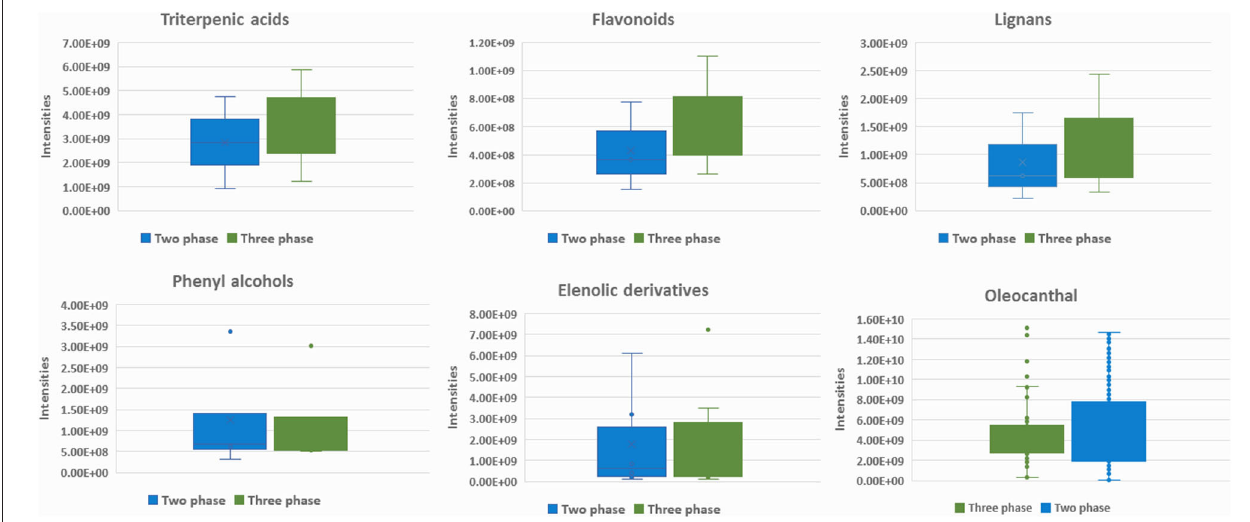
FIGURE 9 | Box-plots representing intensities of statistical significant compounds grouped according to their chemical class: triterpenic acids, flavonoids, lignans, elenolic derivatives phenyl alcohols, and oleocanthal ( 32 ) from secoiridoids class. Box-plots are presented according to production procedure system: two phase (blue) and three phase